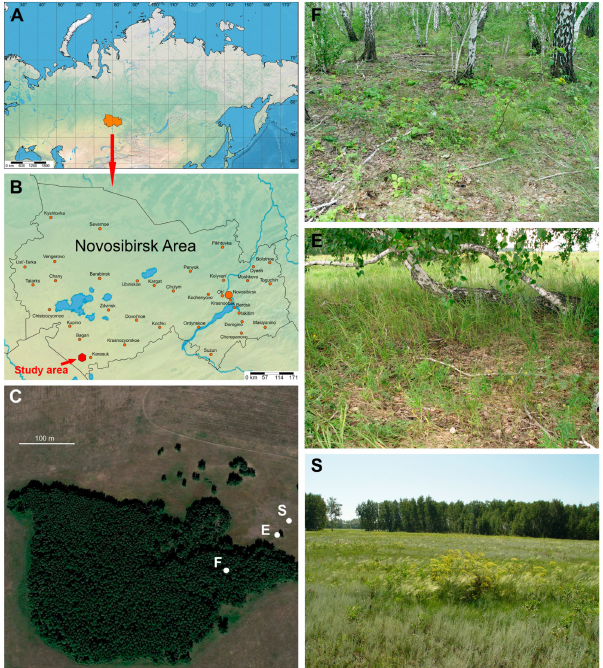
Figure 1. Geographical location of the study area. ( A ) Novosibirsk region, ( B ) location of the study site on the map of the Novosibirsk region. ( C ) Location of the studied habitats (( F ) forest, ( E ) edge, ( S ) steppe). Scale bar—100 m. General view of habitats: ( F ) forest, ( E ) forest edge, ( S ) steppe. All photos were taken on 20 July